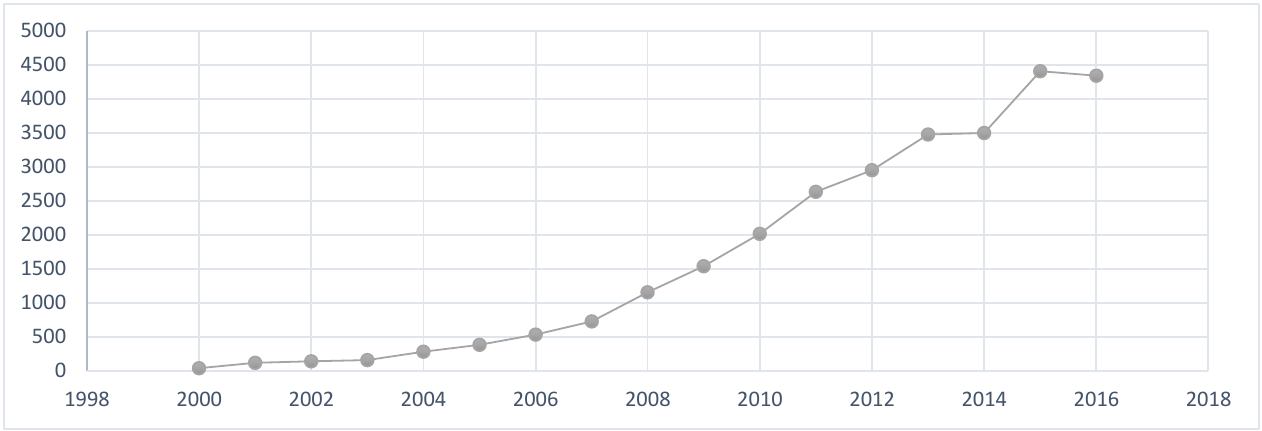
Figure 3. The number of companies worldwide publishing sustainability reports in 2000–2016 (GRI, 2018). Sources: based on [35].